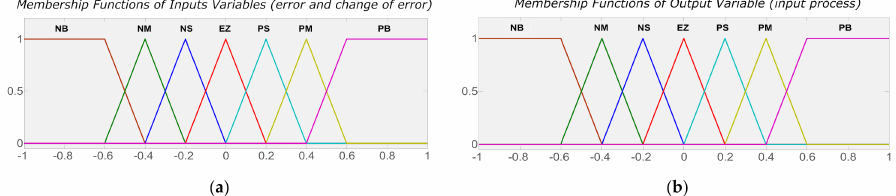
Figure 5. Type-1 fuzzy membership functions (MFs): ( a ) MFs for input variable ‘e’ and ‘de’ of the T1-FLC; ( b ) MFs for output variable ‘u’ of the T1-FLC.